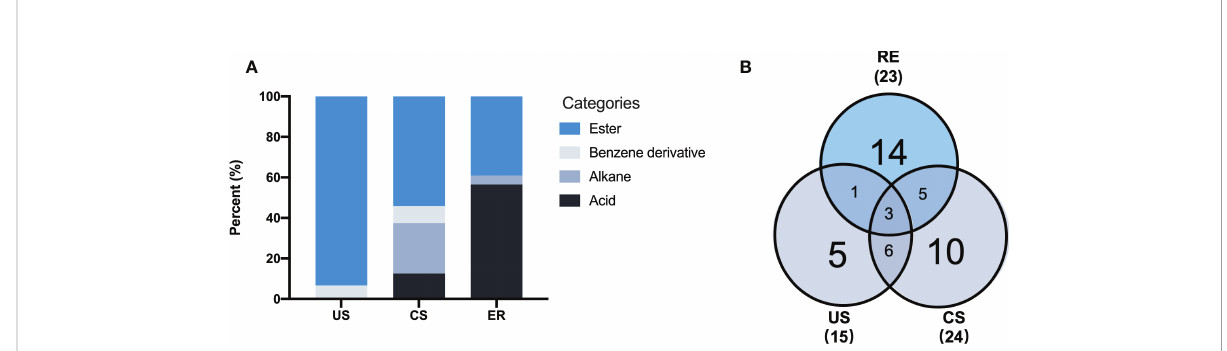
FIGURE 4 Categories of the metabolites identi fi ed from the soils and root exudates by GC-MS analysis (A) , The Venn diagram shows the number of metabolites detected in soils and root exudates samples (B) . The Numbers in brackets represent the total number of identi fi ed metabolites in each group. Additional CS-MS chart can be found in Supplementary